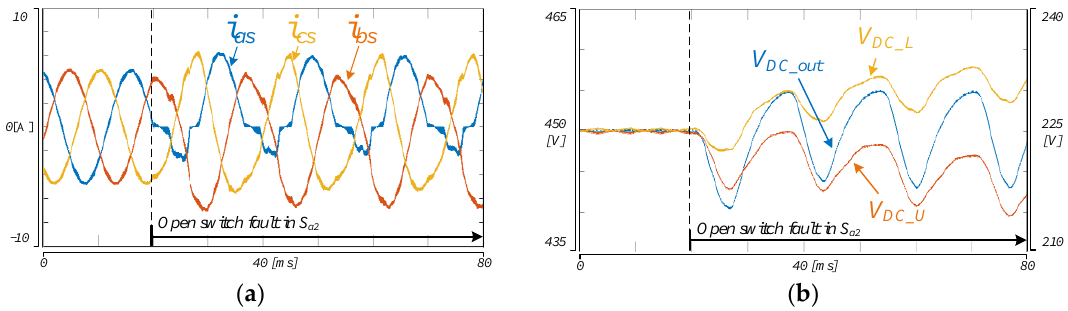
Figure 3. Three-phase currents and DC-link capacitor voltages under S x2 open-switch fault condition: ( a ) three-phase input current ( S a 2 ); ( b ) DC-link capacitor voltage ( S a 2 ).